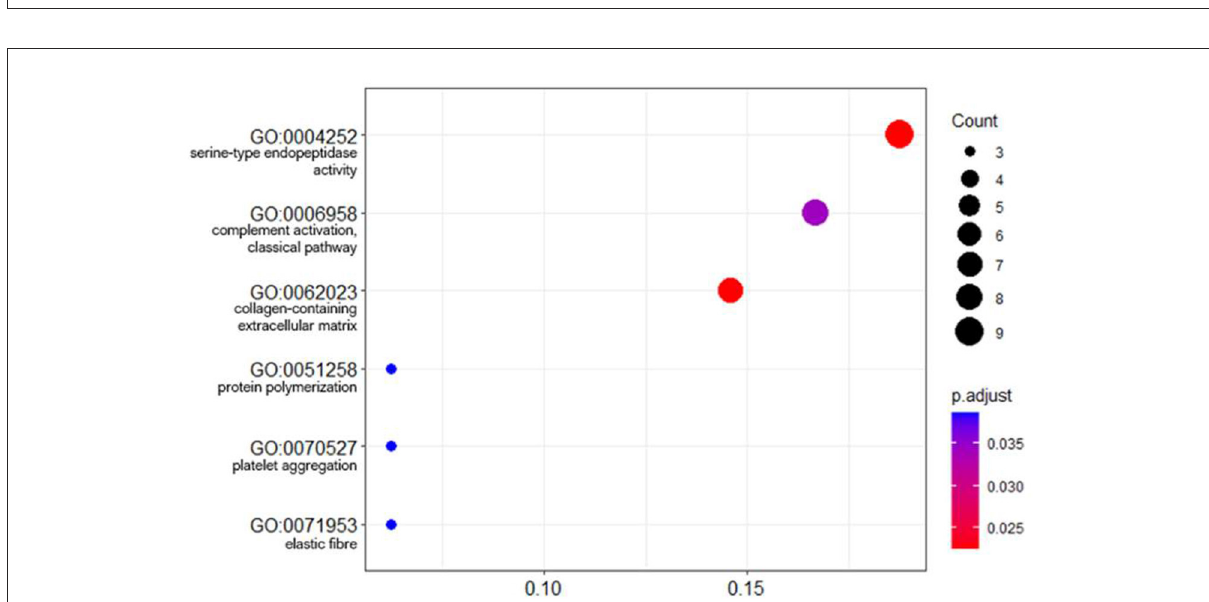
FIGURE7 Dot plot of GO term enrichment analysis of differentially abundant proteins. The size of the dots indicates the number of proteins that mapped to that term. The x-axis is the protein ratio (number of proteins that map to the term divided by the total number of significant proteins). The dots are shaded by adjusted p -values (BH